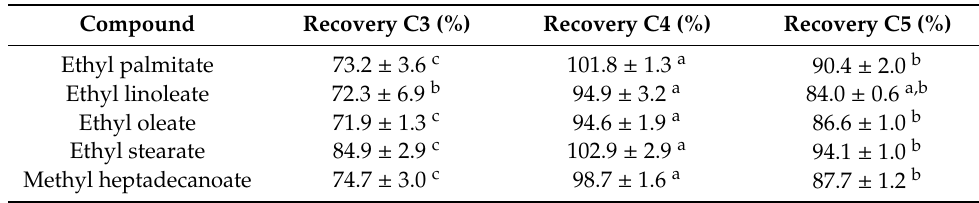
Table 3. Recovery percentages, calculated analyzing the mix of standards at 3 concentrations (C3, C4, C5) for the fatty acid ethyl esters (FAEEs)